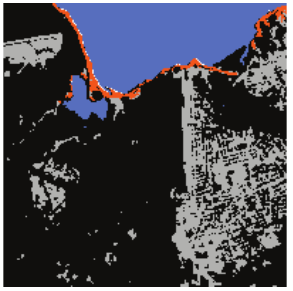
Figure 15: Semantic classification with spatial relations inference.